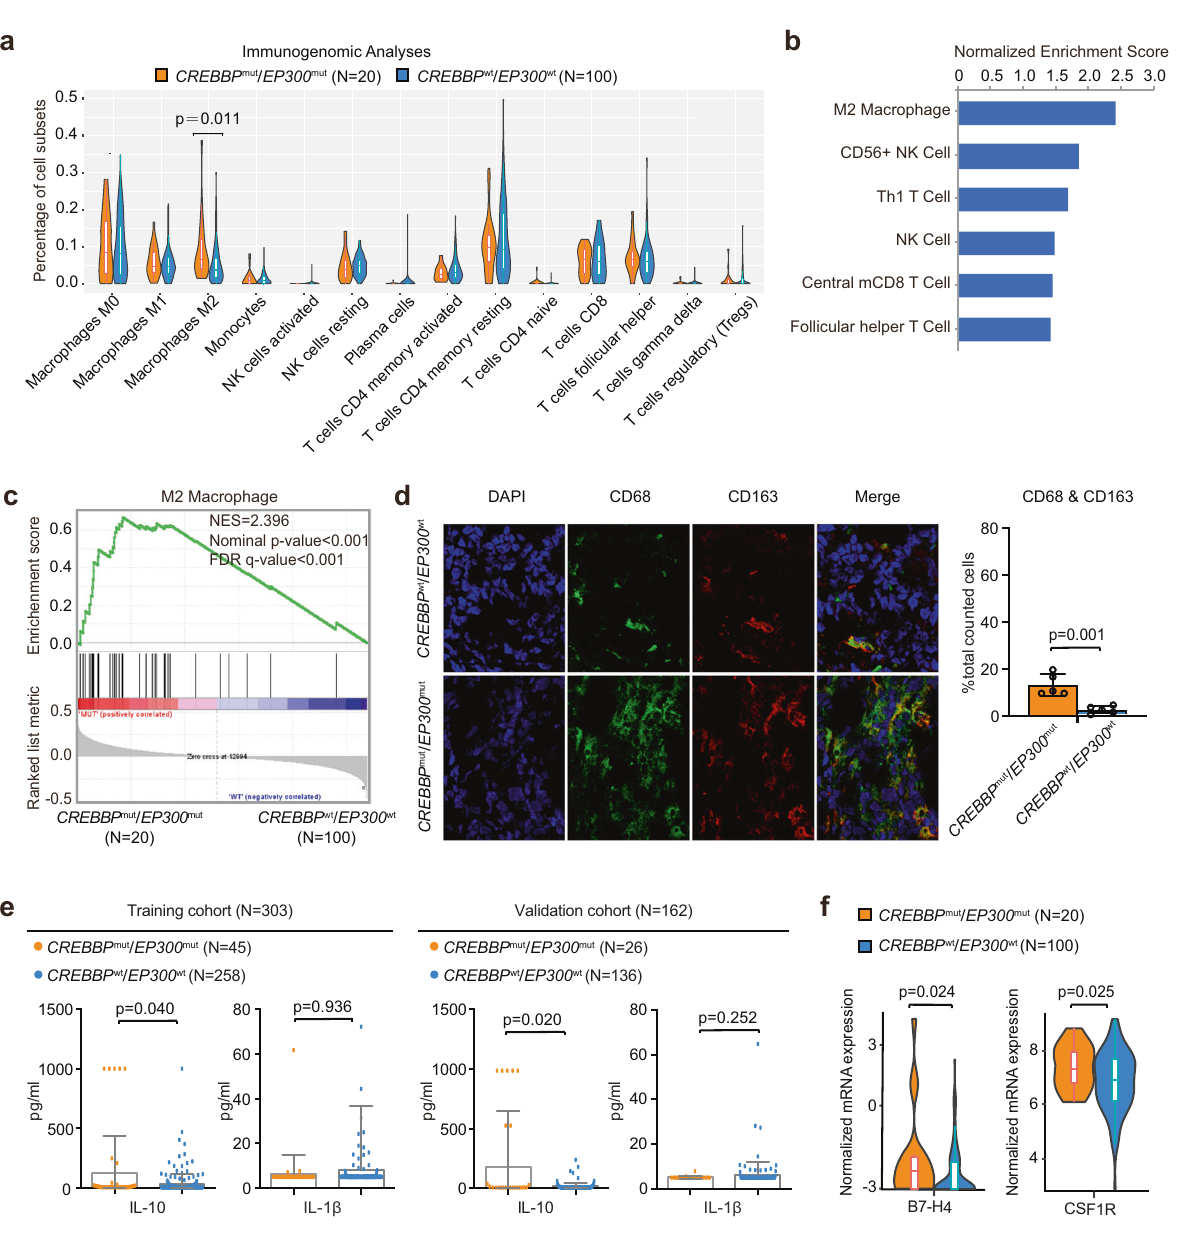
Fig. 5 CREBBP/EP300 mutations contributed to macrophage activation and polarization. a Distribution of immune subpopulations in diffuse large B-cell lymphoma (DLBCL) patients with or without CREBBP / EP300 mutations analyzed by computational deconvolution of transcriptomics data using Cibersort. b Prediction of immune subpopulations normalized enrichment scores for DLBCL patients with CREBBP / EP300 mutations using GSEA. Immune cells with P < 0.05 are listed. c GSEA showing association of M2 macrophage gene signatures with CREBBP / EP300 mutations in DLBCL patients. NES normalized enrichment score, FDR false discovery rate. d Confocal analysis of CD68 and CD163 in DLBCL patients with or without CREBBP / EP300 mutations. The cells were counted from fi ve randomly selected visions and subjected for statistical analysis. Data are presented as the mean ± SD. e Chemiluminescence immunoassay of IL-10 and IL-1 β in the training and validation cohorts of DLBCL patients according to CREBBP / EP300 mutations. Data are presented as the mean ± SD. f Normalized mRNA expression of immune inhibitors (B7-H4 and CSFR1) in DLBCL patients with or without CREBBP / EP300 mutations as revealed by RNA sequencing between tumor and normal samples. The copy number pro fi le of each tumor sample was quanti fi ed by log2 ratio of reads relative to the normal samples. Signi fi cant gained or lost copy number aberrations (CNAs) were identi fi ed by Genomic Identi fi cation of Signi fi cant Targets in Cancer (GISTIC, version 2.0) with default parameters. 51 CNAs of chromatin-modifying genes were calculated for focal homozygous deletions or high- level (copy number ≥ 3) ampli fi cations referring to a log2 ratio cutoff of ±0.8. 52